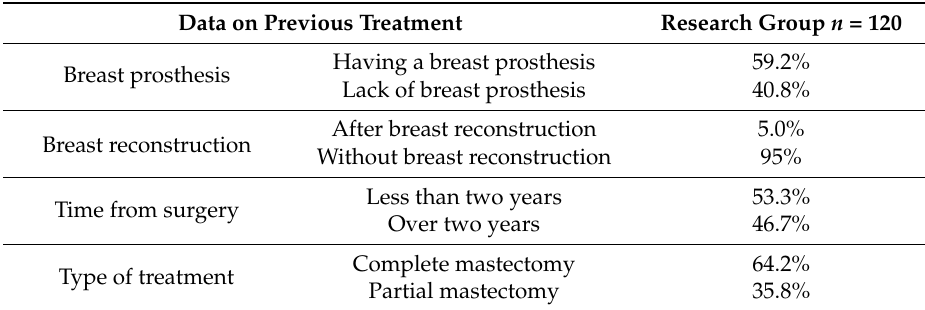
Table 2. The characteristics of women in the research group (data related to mastectomy